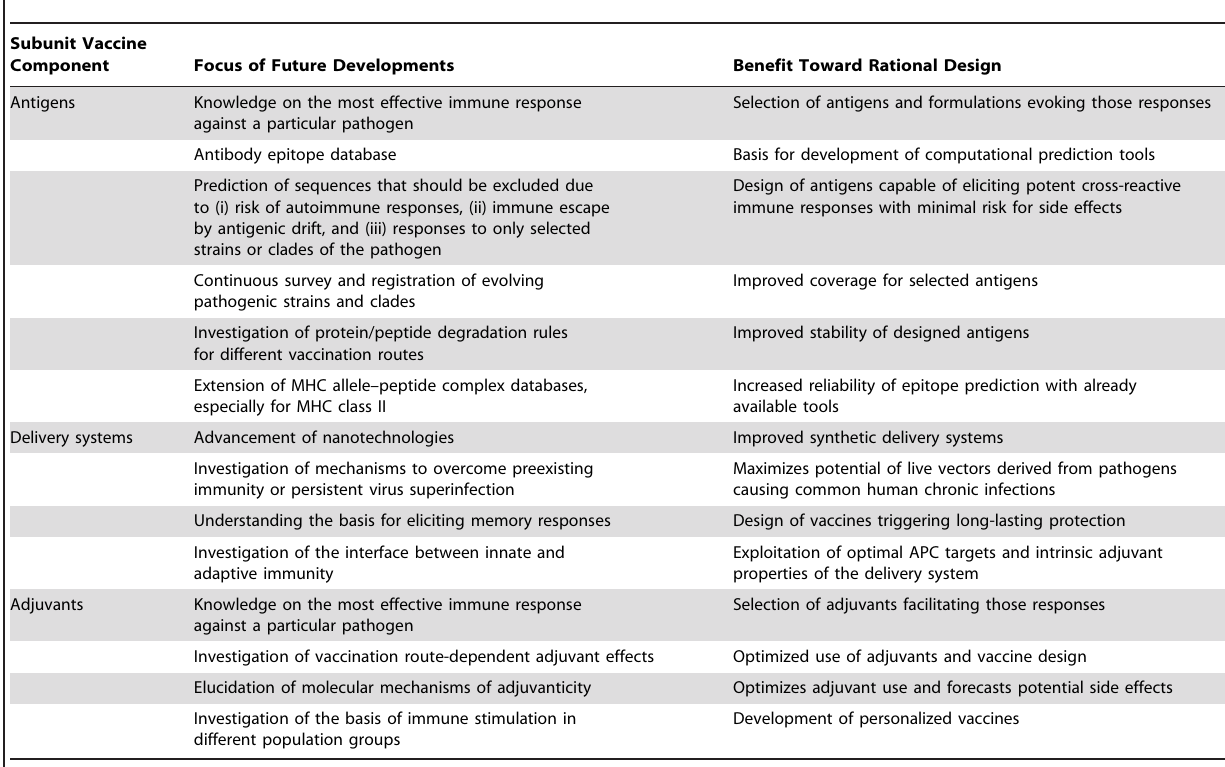
Table 1. Needs and challenges for the rational design of vaccines.